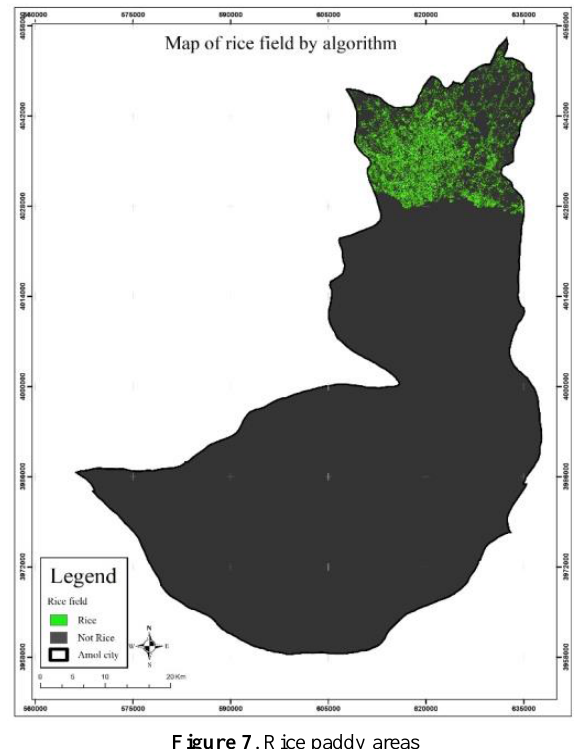
Figure 5 . Evergreen cover area